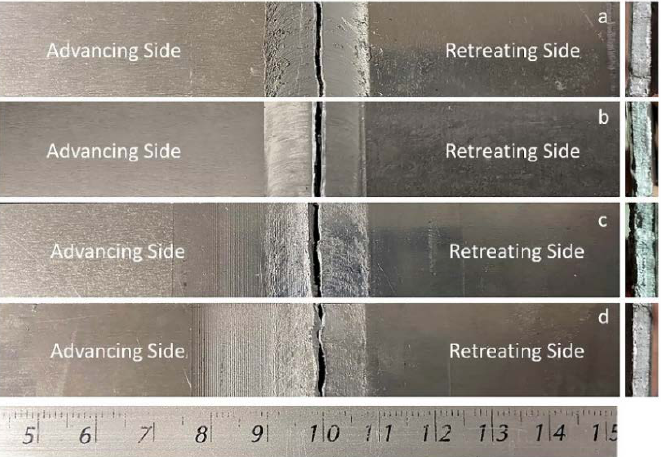
Figure 20. Photographs of the broken workpieces from fatigue life testing: ( a ) FSW; ( b ) FSW-PWHT; ( c ) FSW-DR; ( d ) FSW-PWHT-DR.